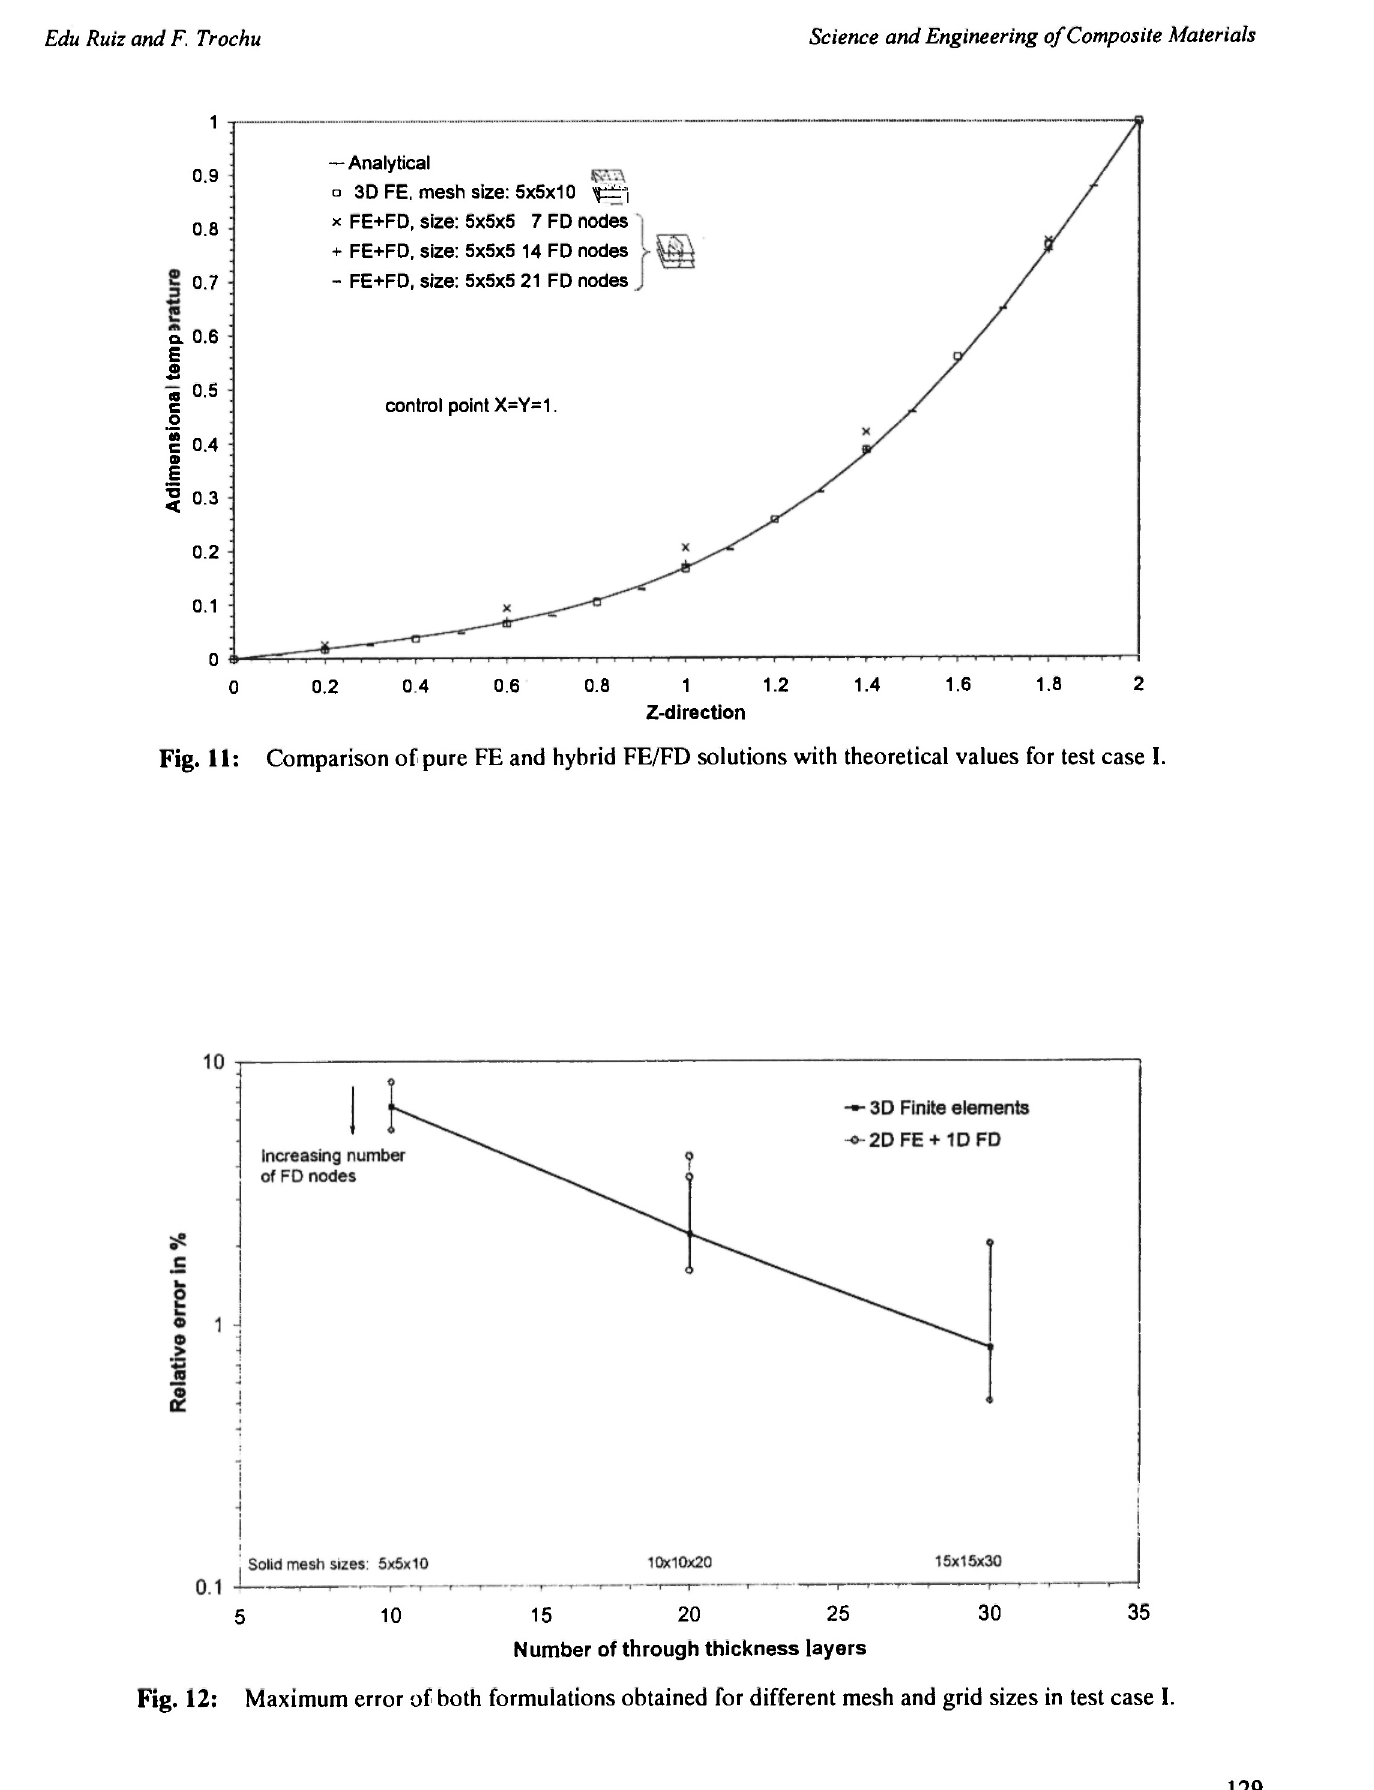
Fig. 12: Maximum error of both formulations obtained for different mesh and grid sizes in test case